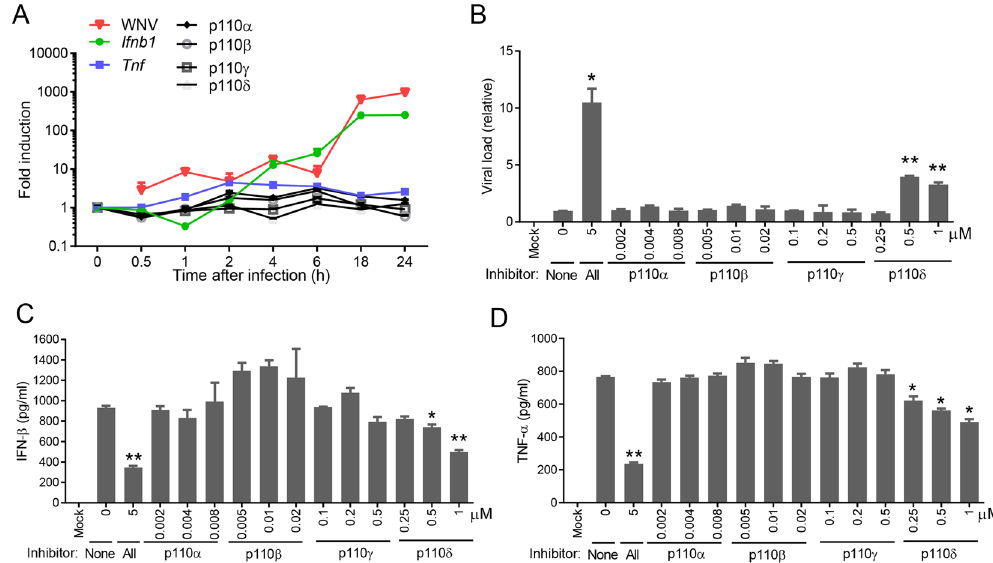
Figure 4. Selective inhibition of the PI3K catalytic p110 δ reduces antiviral immune responses. ( A ) The mRNA abundances of Ifnb1 , Tnfa and p110 isoforms during the course of WNV infection were quantified by q-PCR. The results are expressed as fold change over uninfected (0 h after infection). ( B–D ) BMDMs were left untreated (mock) or infected with WNV in the presence of 5 µ M of a pan-PI3K inhibitor LY294002 (All) or various concentrations of p110 isoform-specific inhibitors for 24 h. None: no inhibitor. ( B ) The cellular viral loads were quantified by q-PCR. The data are expressed as fold change over None. ELISA of ( C ) IFN- β and ( D ) TNF- α levels in the cell culture media. * p < 0.05, ** p < 0.001 (unpaired Student’s T-test), Bar: the mean of the result + s.e.m. The data shown are representative of 3 independent reproducible experiments.